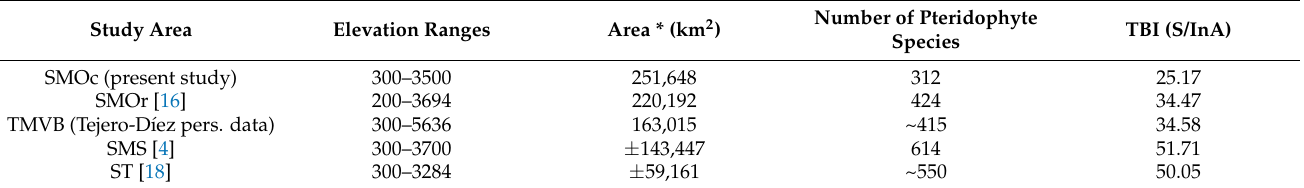
Table 2. Taxonomic biodiversity index (TBI) of the study area compared with other areas and mountain chains of Mexico.